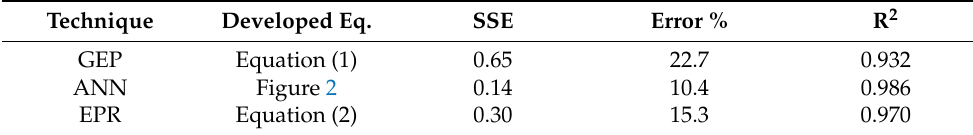
Table 4. Accuracies of developed